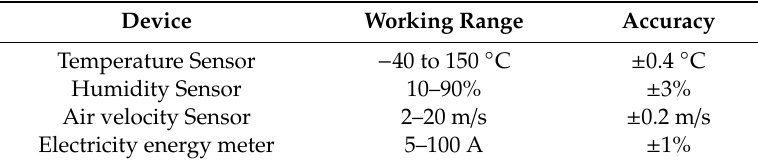
Table 3. Specifications of the sensors and instruments.